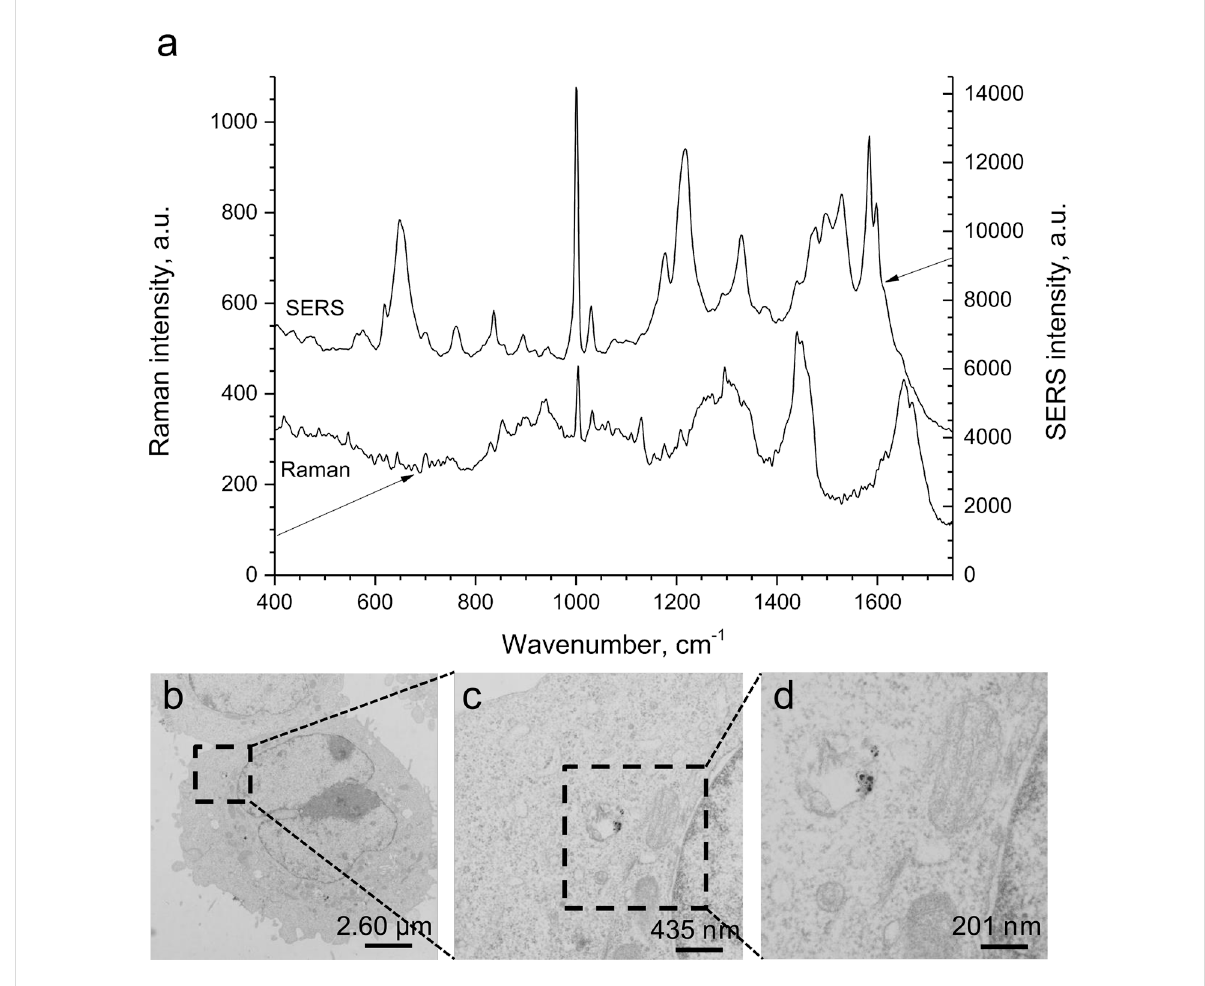
Figure 2: Skin penetration and cellular uptake of silver nanoparticles (AgNP). While studies with silica particles required labeling of particles with fluo- rescent dyes or introduction of gold cores followed by sectioning of the tissue for further analysis, skin penetration of AgNP could be studied in intact tissue blocks by tracking of the Raman signal. The representative Raman and SERS typical spectra were obtained in intact porcine skin (depth 4 µm) pre-treated with AgNP, excitation wavelength 785 nm, power on the sample 25 mW, analyzing range 400–2000 cm − 1 (a). Label-free detection of AgNP also facilitated studies on cellular uptake by HaCaT cells by using TEM. In the representative TEM images of HaCaT cells (obtained after incu- bation for 24 h with 25 µg/mL AgNP) AgNP are accumulated in endosomes